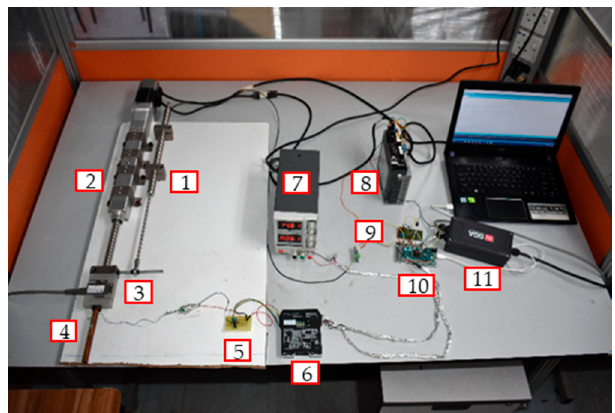
Figure 2. Experimental Setup of data acquisition system for pinch assessment.